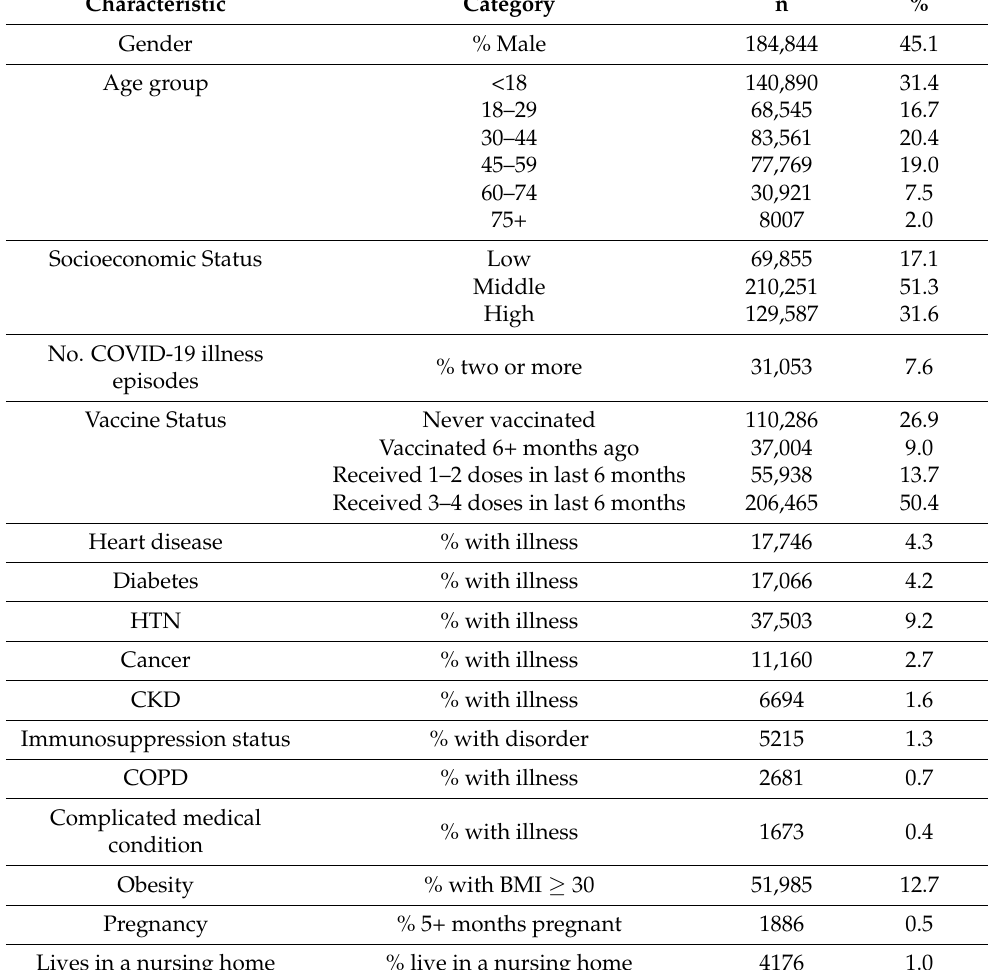
Table 1. Demographic and Health Characteristics of COVID-19 infected population (N = 409,693), 26 November 2021–27 January 2022, Maccabi HealthCare Services,